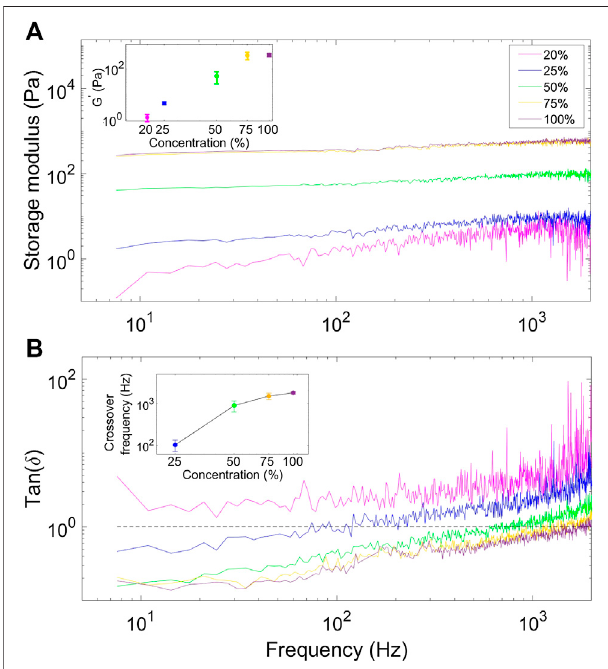
FIGURE 4 | Analysis of how the elastic properties of the matrix change with polymer concentration. (A) Storage moduli of mixtures with different Matrigel concentrations (20% magenta, 25% blue, 50% green, 75% orange, and pure Matrigelsolution (100%) purple). Atall frequencies, the storage moduli increase with Matrigel concentration. The inset shows the value of the storage modulus at f (cid:1) 100 Hz as a function of Matrigel concentration. (B) Loss tangents as a function of frequency for different Matrigel concentrations. The insert shows the valueof thecrossover frequency, the frequencyat which tan ( δ ) (cid:1) 1, as a function of concentration. The cross-over frequency marks the frequency at which the solution shifts from solid- to liquid-like behavior. The data were collected 7 h after the sample